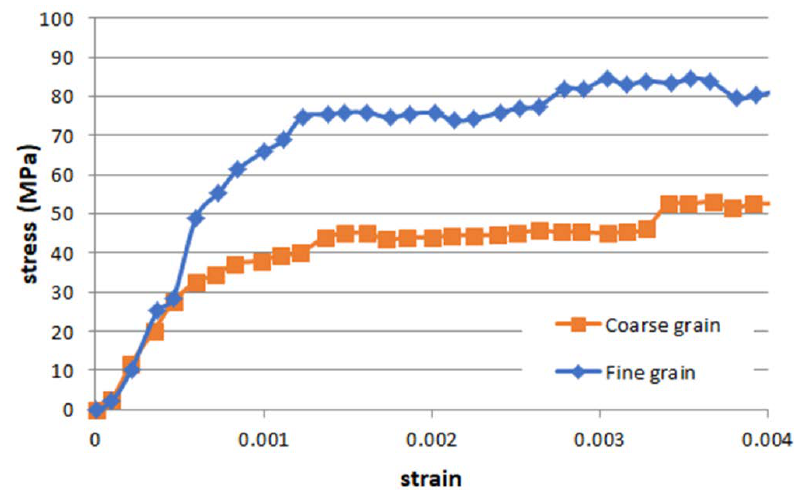
Figure 2. Comparison of the stress–strain curve of fine grain (average grain size—14.2 µm) and coarse grain (average grain size—104.2 µm) samples.